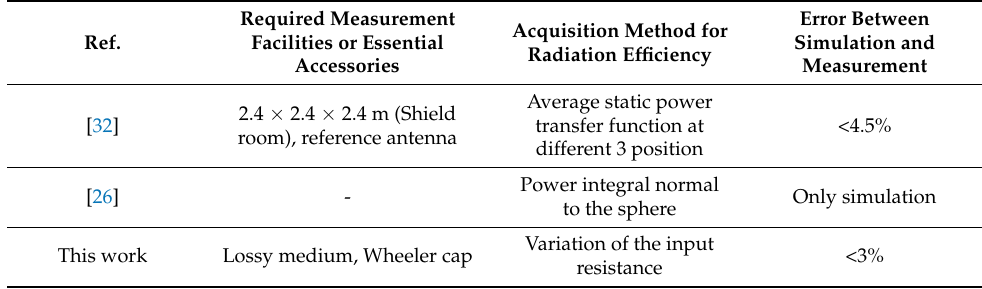
Table 2. Comparison of the proposed method with other works.